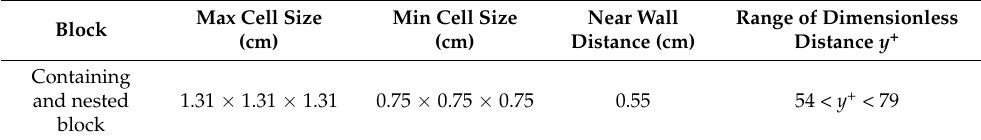
Table 5. Grid details in the numerical